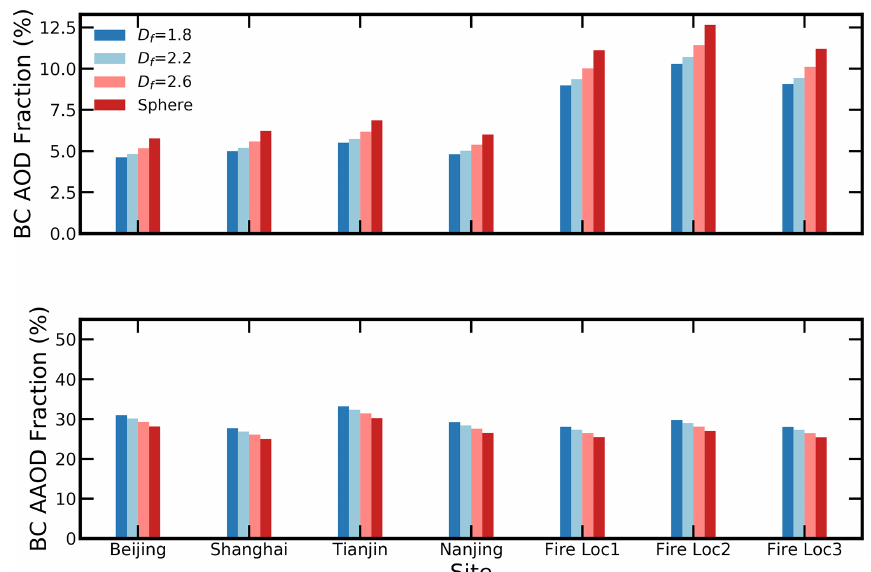
Figure 9. BC AOD (550nm) and AAOD (450nm) as a percentage of total AOD and AAOD.